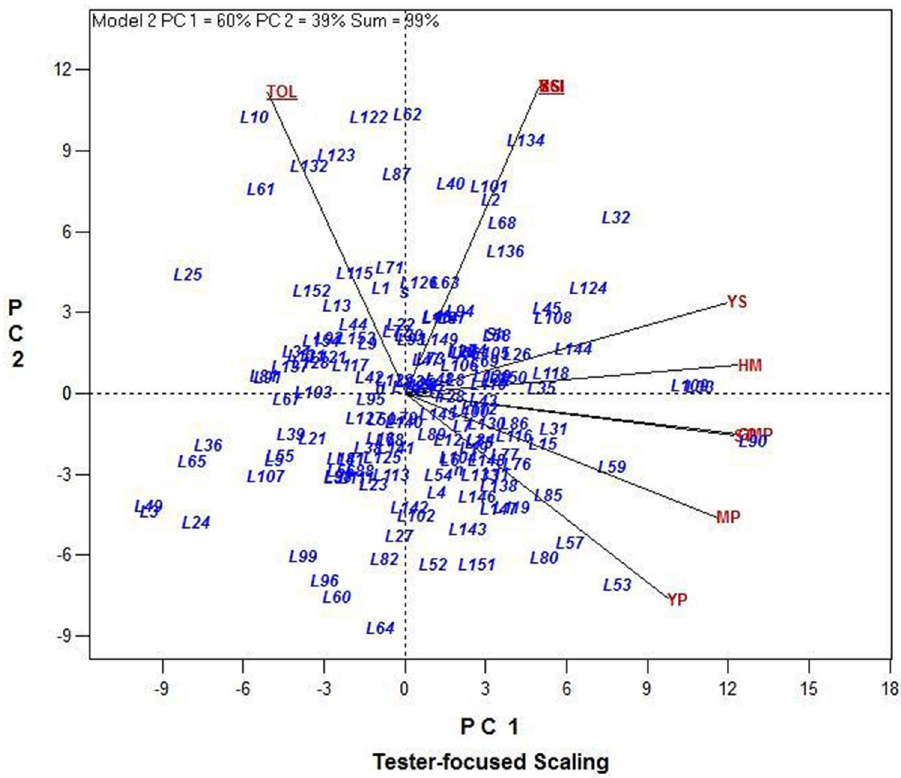
Figure 4. GT-biplot for different drought tolerance indices based on average of grain yield of 152 rice RILs, parental (IR28 and SH: Shahpasand) and check varieties (N; Neda, S; Sadri, D; Dorfak) under non-stress and drought stress conditions during 3 years from 2017 to 2019. The angles less than 90° between the indices and grain yield represent MP, GMP, STI and HM had strong positive relationship with grain yield under non-stress (YP), and drought stress condition